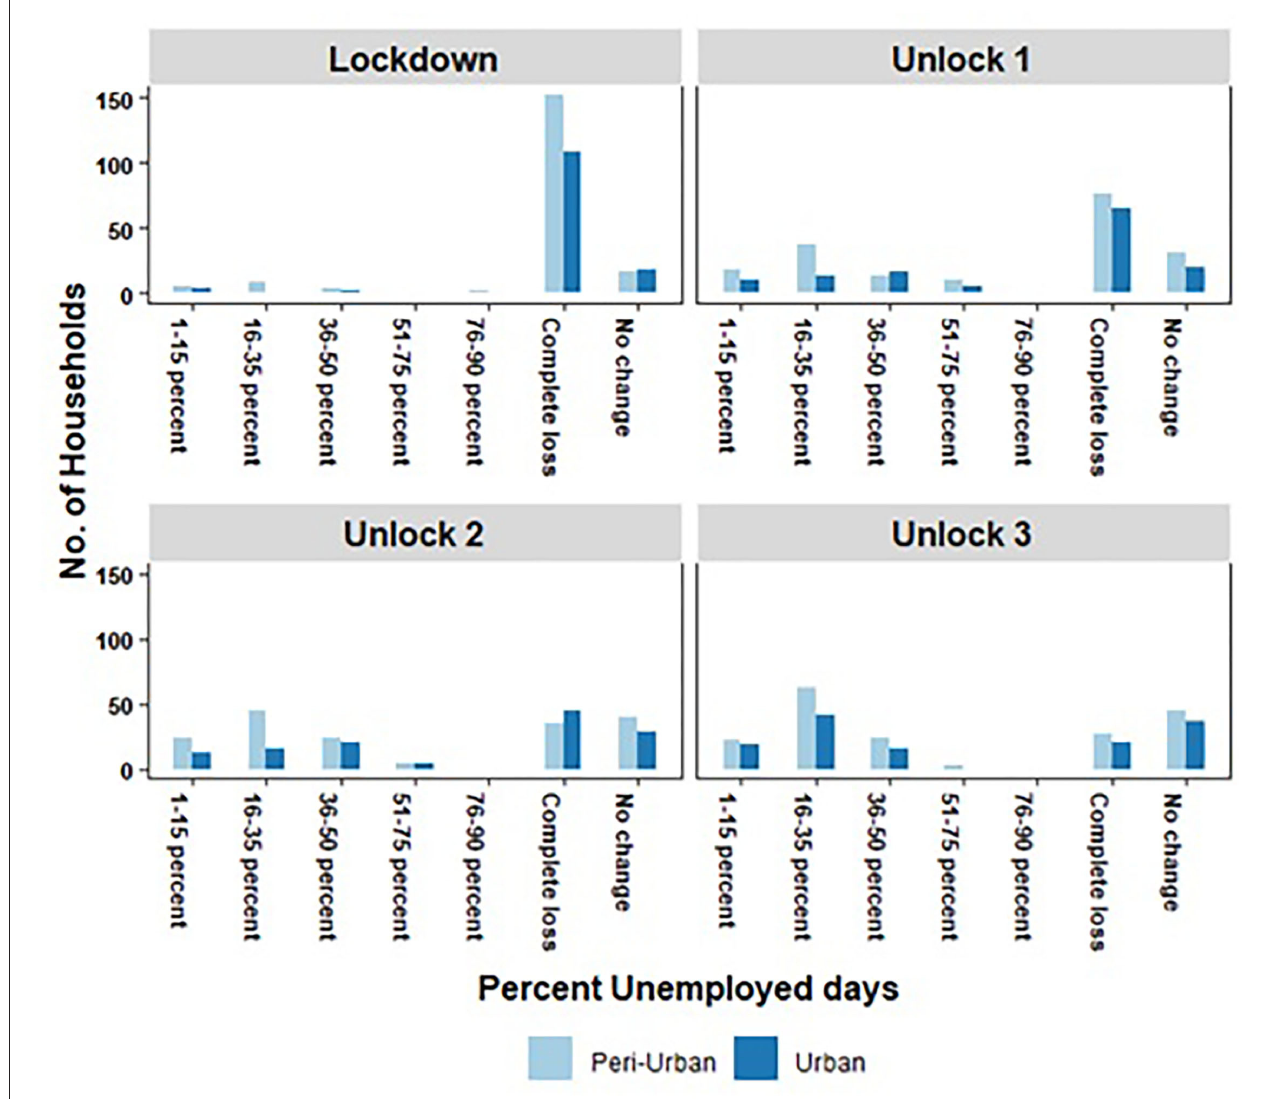
FIGURE 2 | Unemployment (%) experienced by households in urban and peri-urban areas of Hyderabad, India during the COVID-19 lockdown and three-phased unlock (removal of